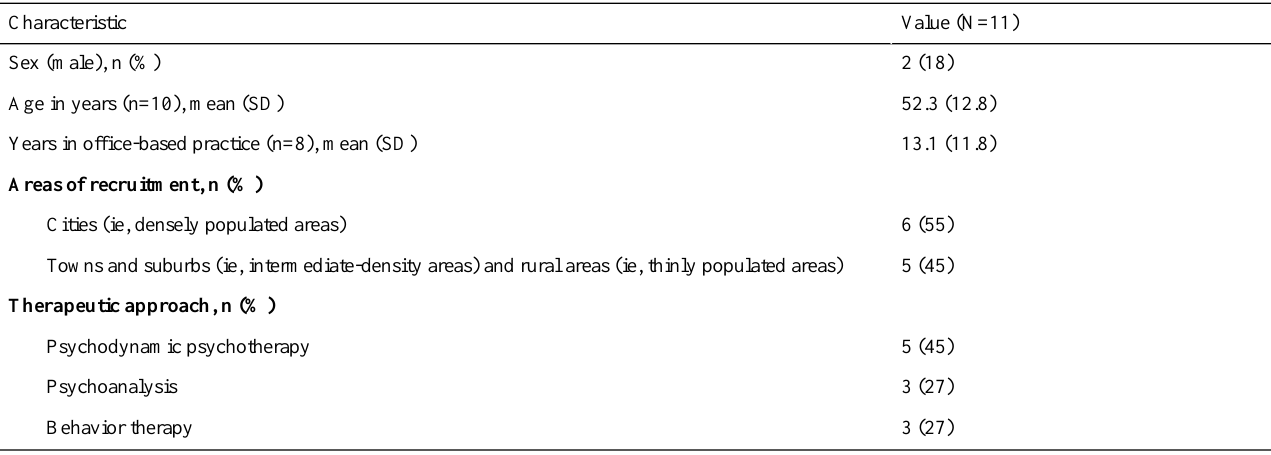
Table 1. Characteristics of the sample